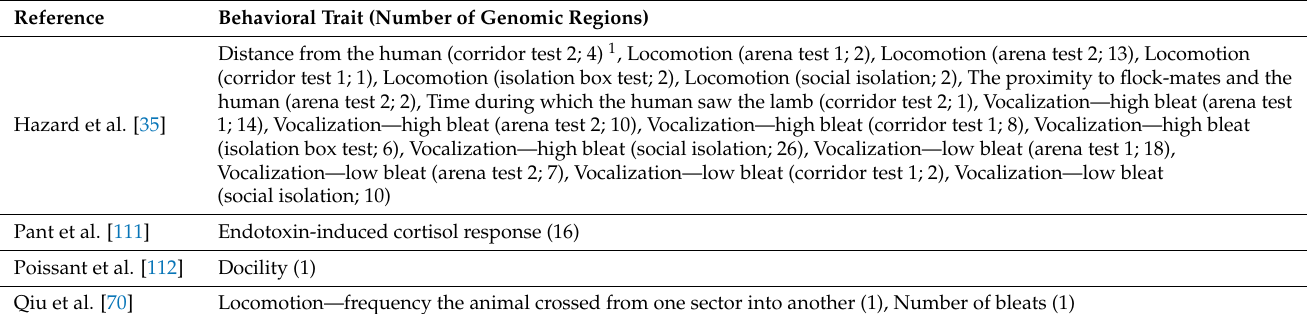
Table 4. References, behavior-related trait, and number of genomic regions identified for sheep.